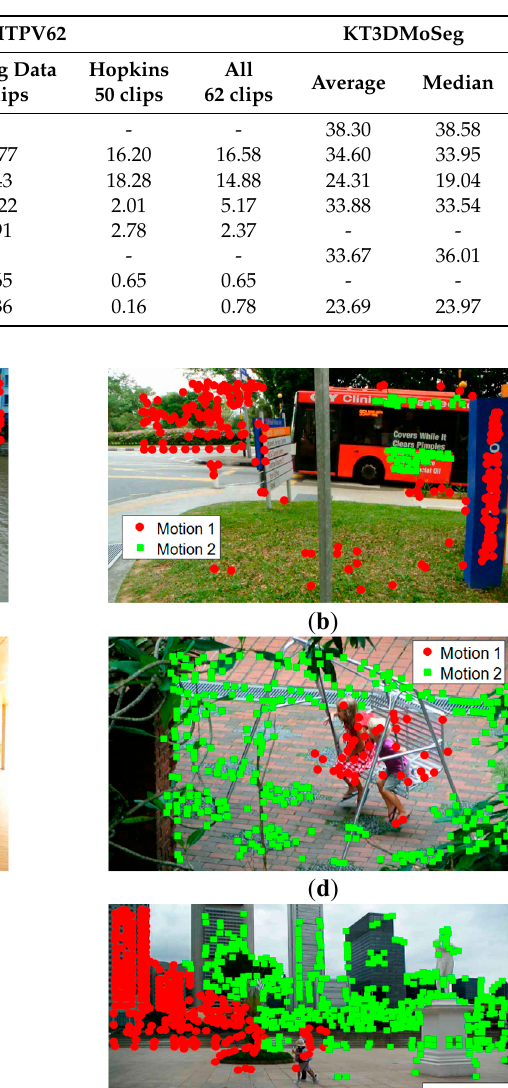
Table 3. Classification errors (%) for sequences with MTPV62 dataset and KT3DMoSeg dataset.